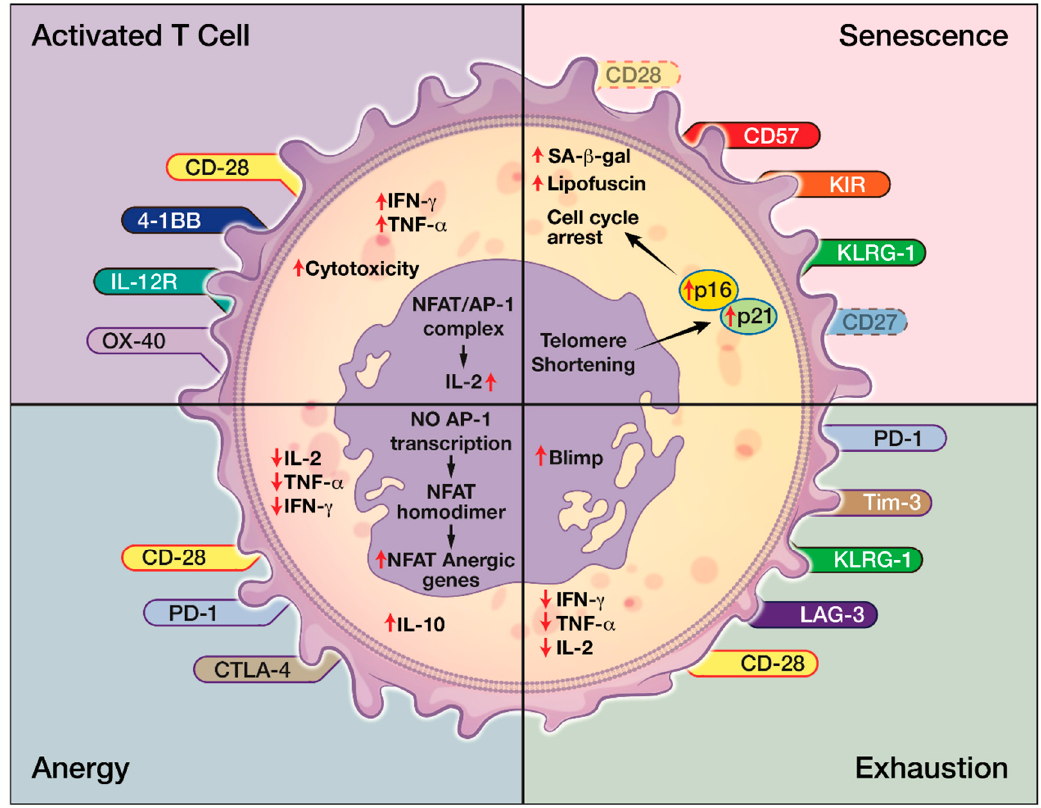
Figure 4. The many facets of C8+ T cell dysfunction. In comparison to activated effector T cells, T